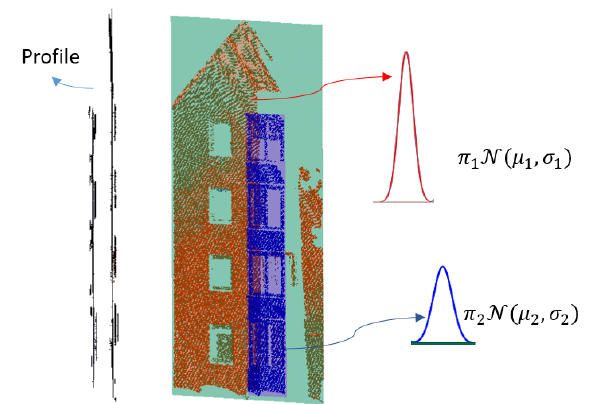
Figure 1. Depth layers depicted by Gaussian components: the red Gaussian component represents the plane of the red points while the blue one depicts the blue plane. The red Gaussian has a higher prior probability π 1 than the blue one π 2 . Note that there are some other small depth planes, such as the one where window casings are located. They are not all shown